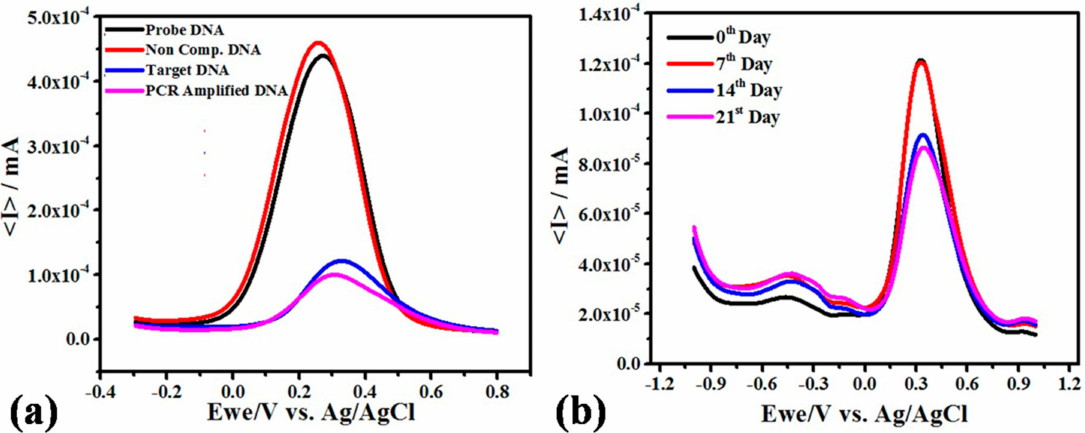
Figure 6. ( a ) Differential pulse voltammogram of ssDNA/MoSe 2 /FTO, ssDNA/MoSe 2 /FTO + non-complementary DNA, ssDNA/MoSe 2 /FTO + complementary DNA; ( b ) ssDNA/MoSe 2 /FTO performance for 5 measurements with four sets of electrodes at room